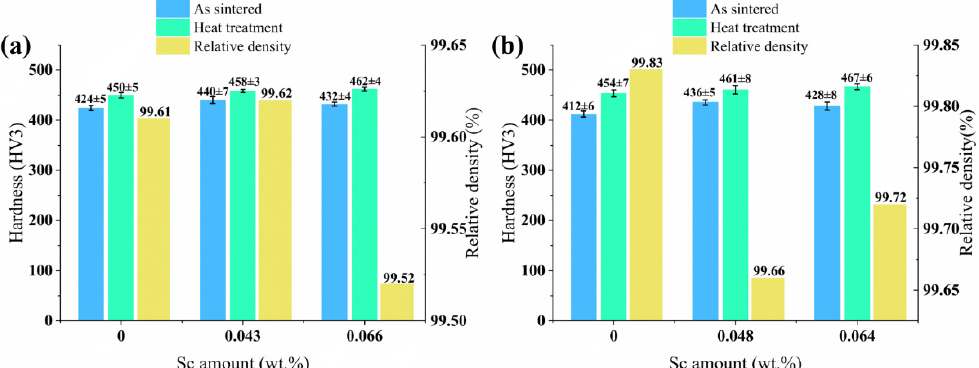
Figure 14. Hardness and relative density of Sc-doped superalloys under di ff erent conditions: ( a ) U720Li, ( b ) RR1000. ( a ) U720Li, ( b )